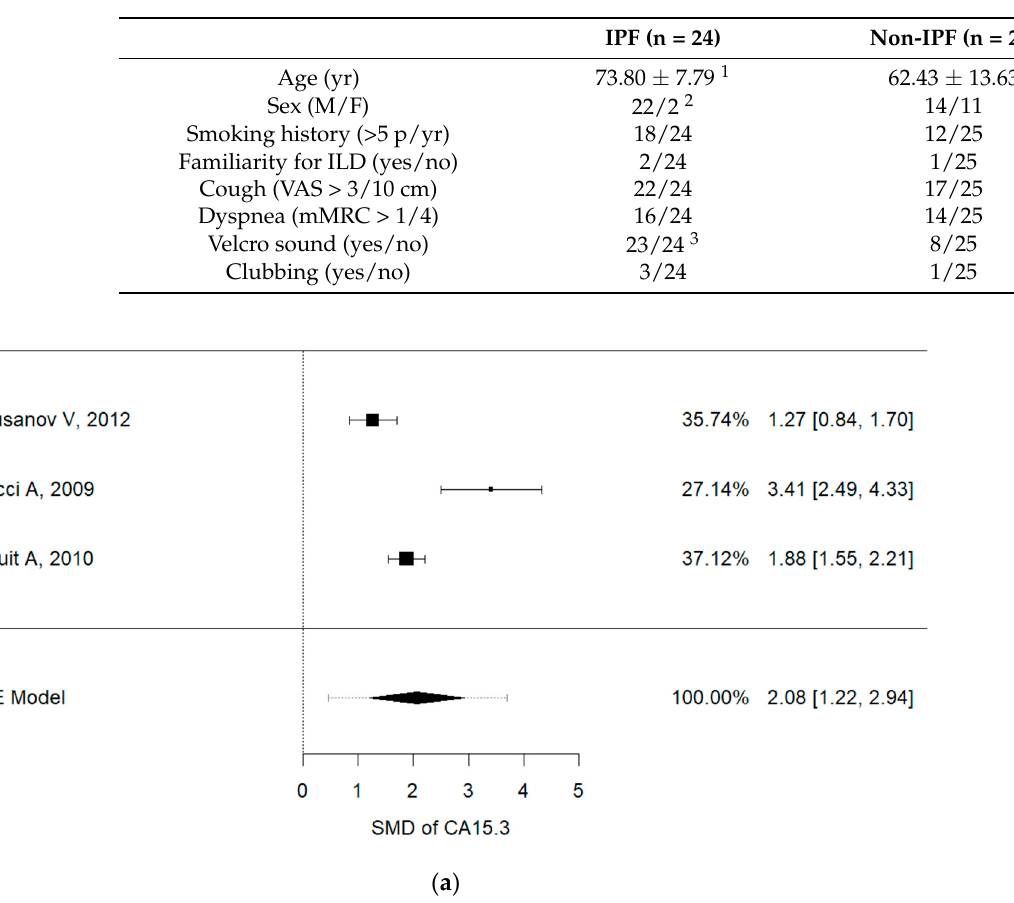
Figure 2. ( a ) Metanalysis results from Ca125 concentrations of selected studies; ( b ) metanalysis results from CEA concentrations of selected studies. Table 1. The main characteristics of our population divided in idiopathic pulmonary fibrosis (IPF) and non-IPF groups. 1 and 2 : older and prevalence of males in the IPF group ( p < 0.05), respectively. 3 . Velcro sound was prevalent in the IPF group ( p < 0.05). Abbreviations: modified Medical Research Council (mMRC).